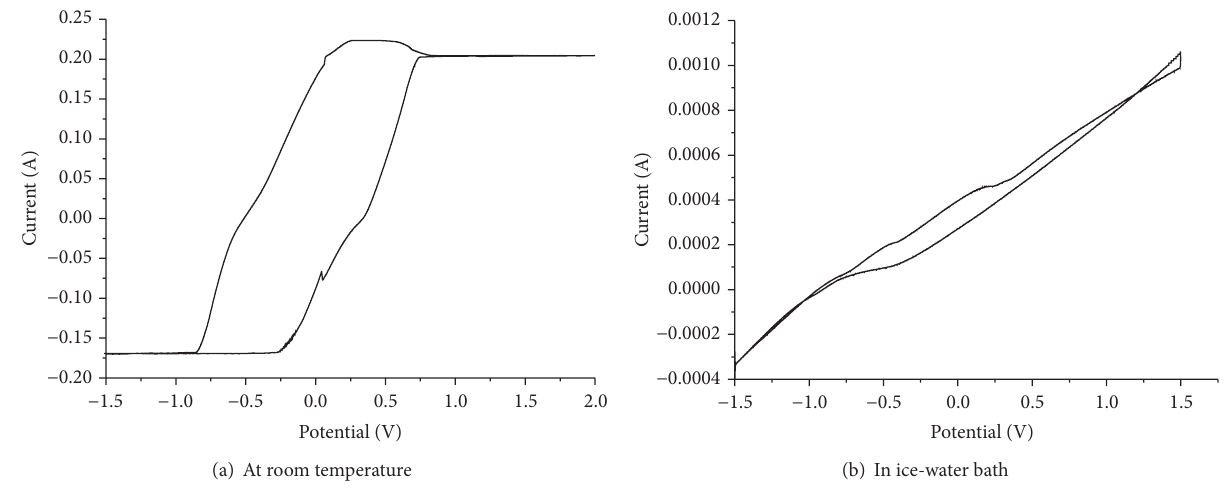
Figure 6: The CV curves of PANI/PVA composite